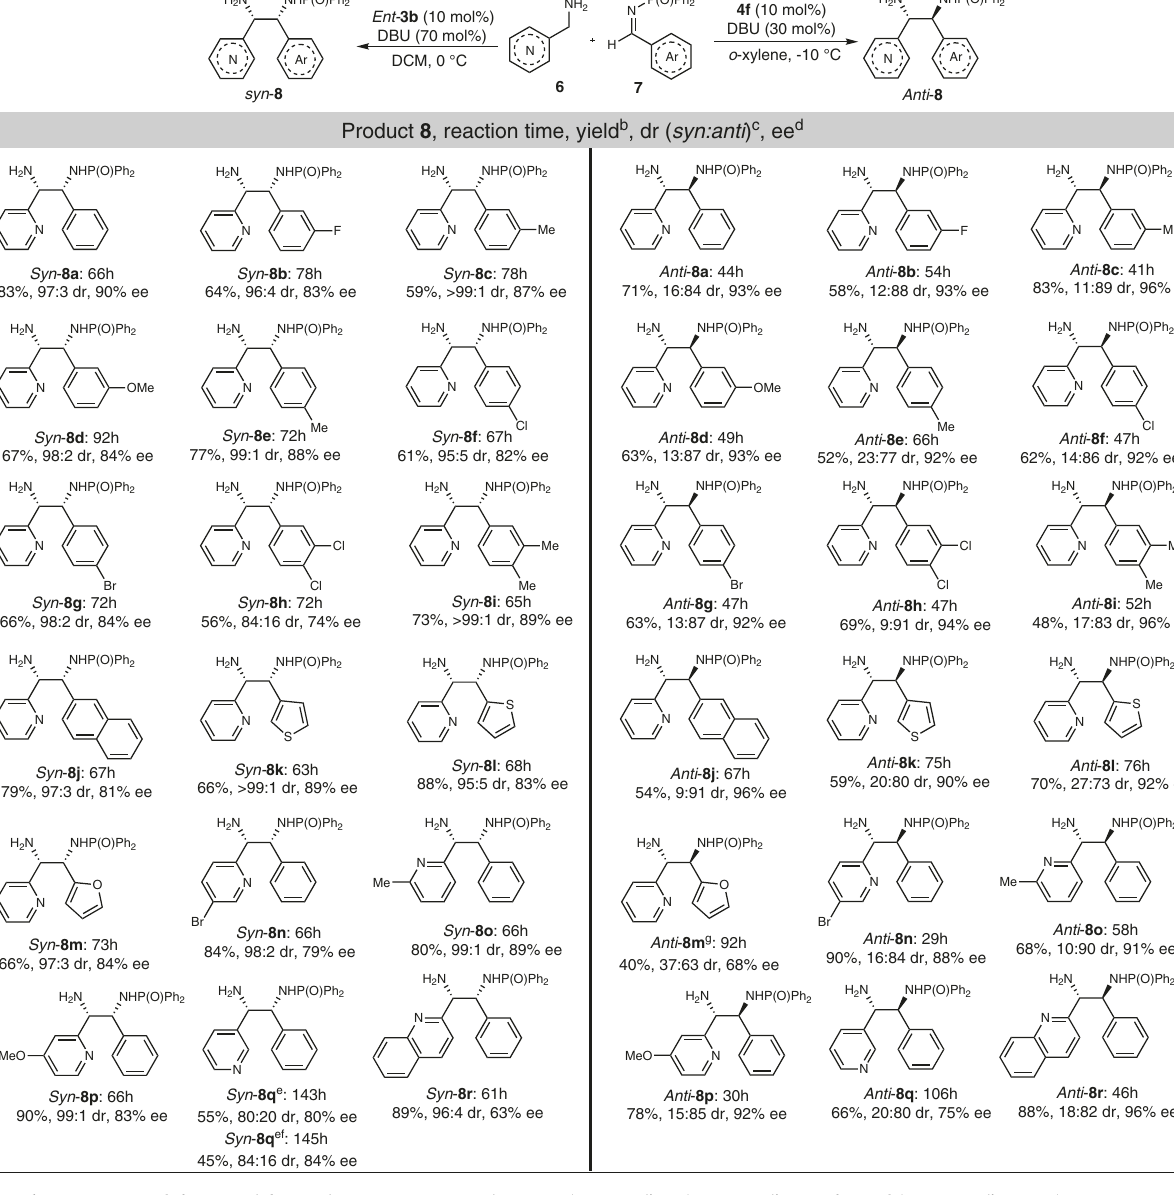
acceptor (Fig. 3, anti - 8i and anti - 8m ). Overall, moderate-to-high diastereoselectivities (37:63 – 9:91) and enantioselectivities (68 – 96% ee) were observed in the anti -selective Mannich reaction; only three products had enantioselectivities lower than 90% ee.